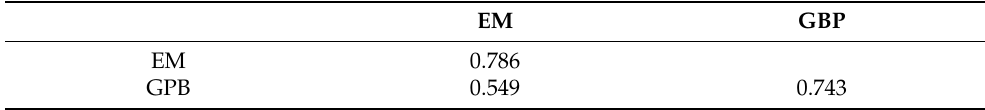
Table 4. The results of discriminant validity